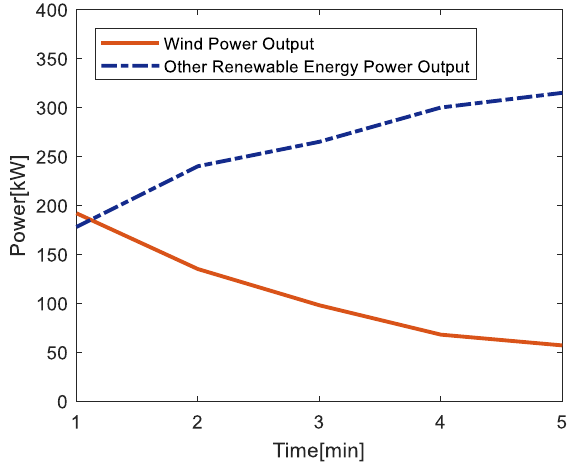
Figure 3. Wind farm power and its corresponding load conditions in period 3.